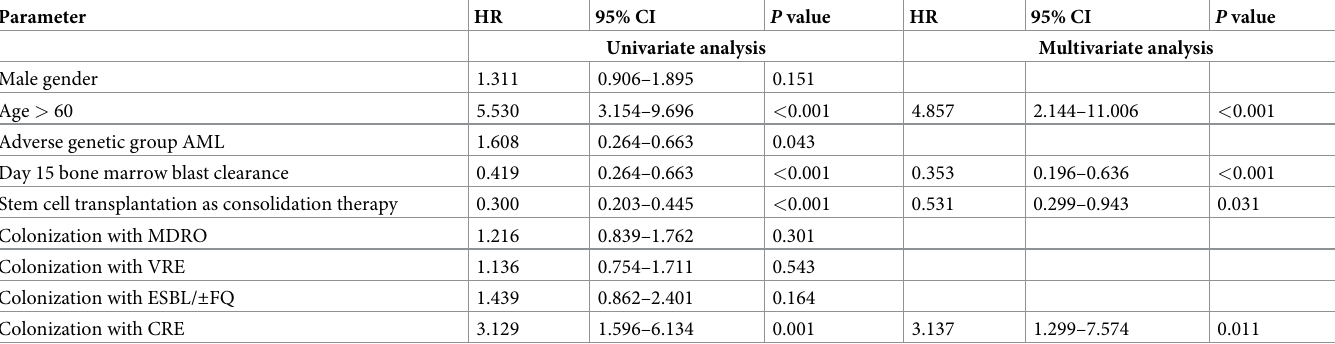
Table 4. Univariate and multivariate analysis associated with survival in AML patients. VRE indicates vancomycin-resistant enterococcus, ESBL/ ± FQ enterobacteria- ceae with extended-spectrum b-lactamase phenotype with or without flourquinolone resistance, CRE indicates carbapenem-resistant enterobacteriaceae, MRSA